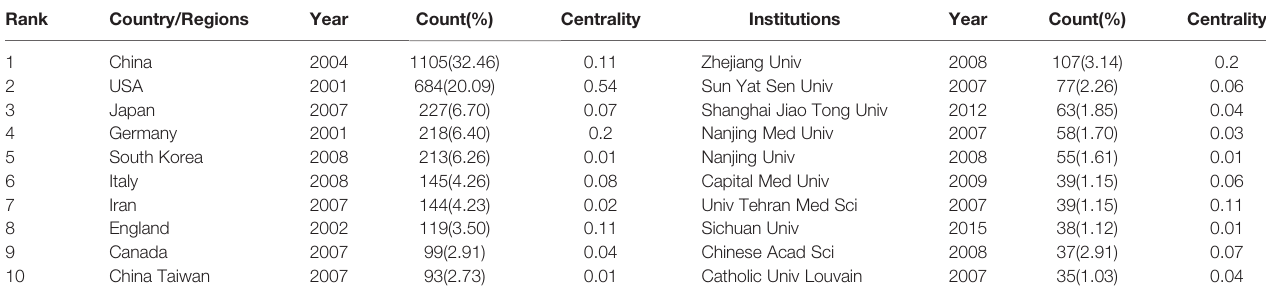
TABLE 2 | Publications in the 10 most productive countries/regions and